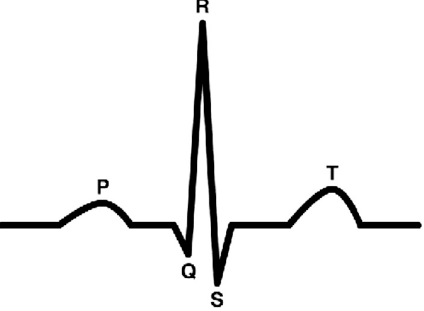
Figure 2. Electrocardiogram (ECG) signal main waves.